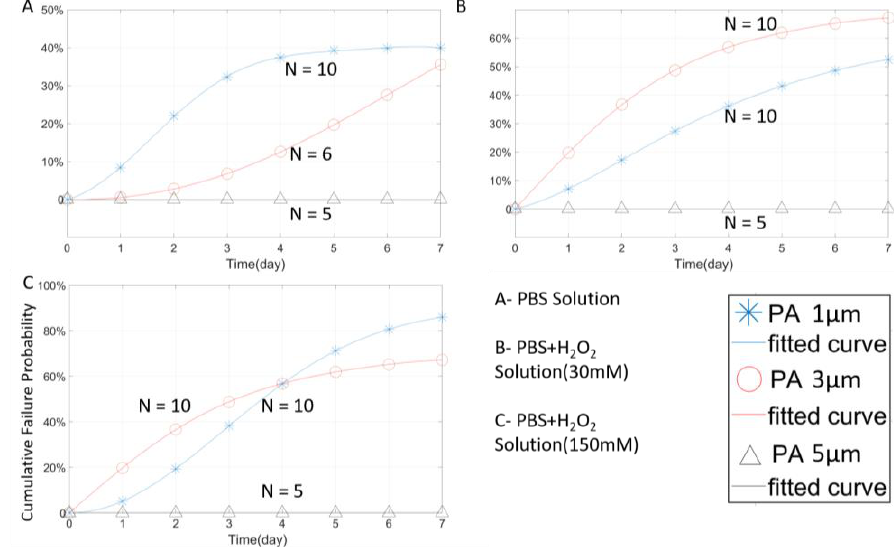
Figure 14. The Weibull cumulative distribution data and the corresponding curve fitting of closed-tip samples with 1 µm, 3 µm, and 5 µm PA. Experiments were performed in different solutions at a temperature of 67 °C.